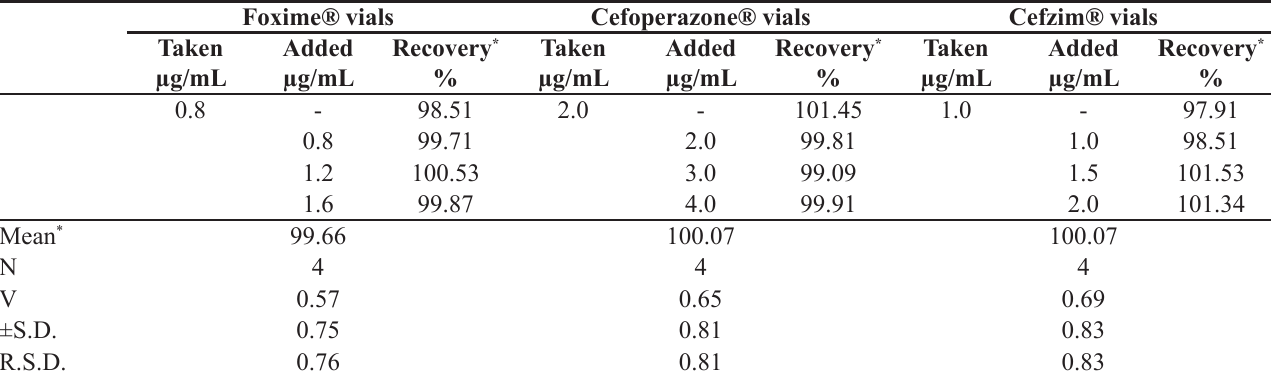
TABLE VI - Application of standard addition technique for the determination of cefadroxil in its pharmaceutical